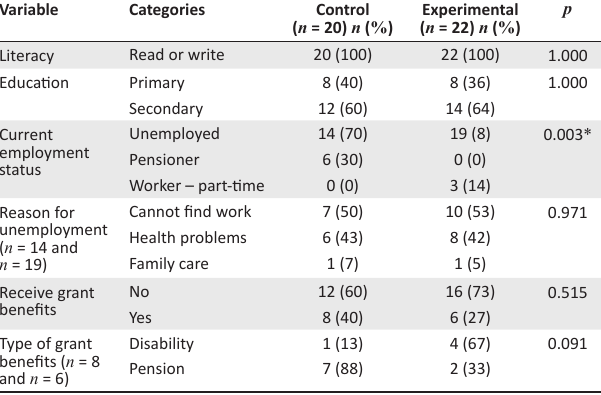
TABLE 2: Comparison of the education level and employment status of the two groups ( n = 42). Variable